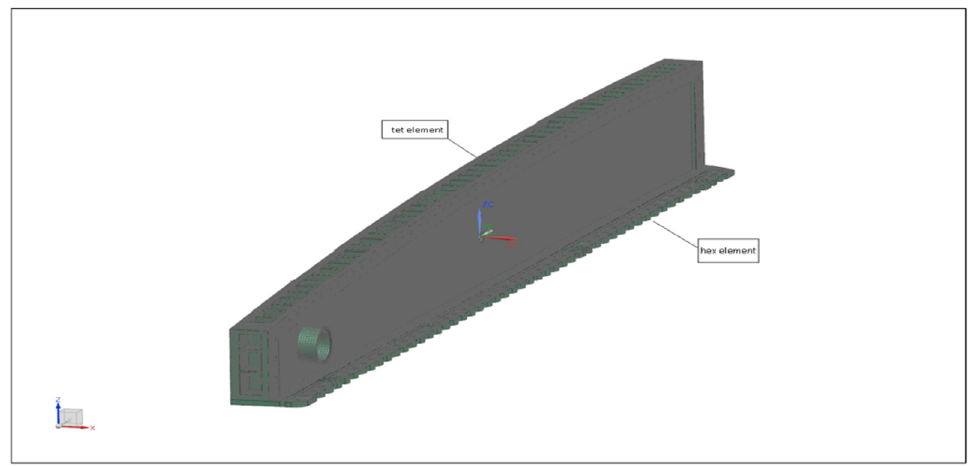
Figure 10. Meshing of the FEA model.